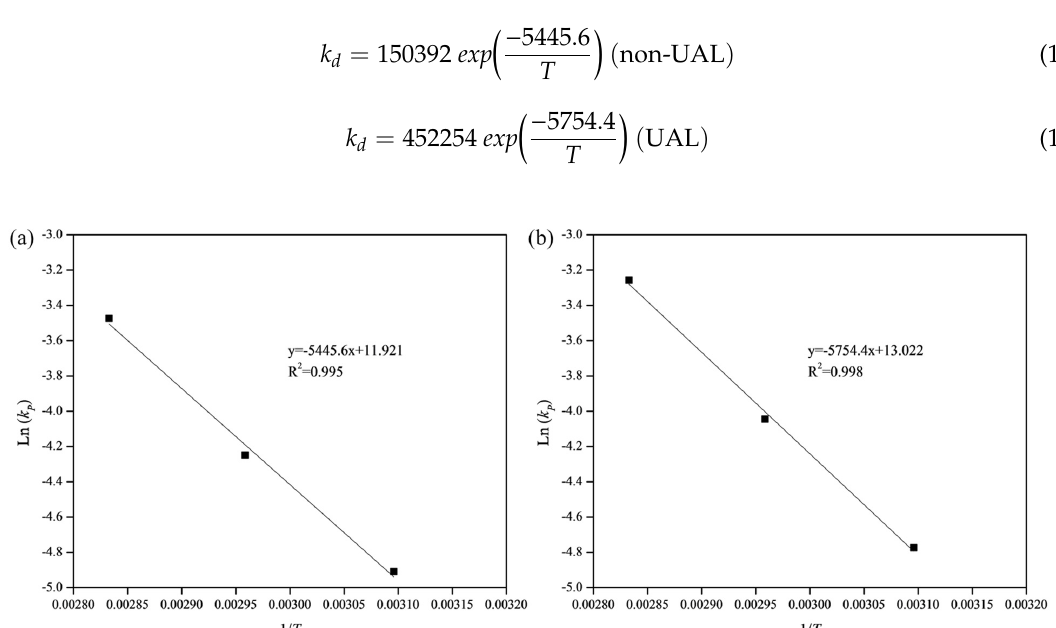
Figure 15. Arrhenius plots from the product layer diffusion obtained for ( a ) non-UAL and ( b ) UAL.